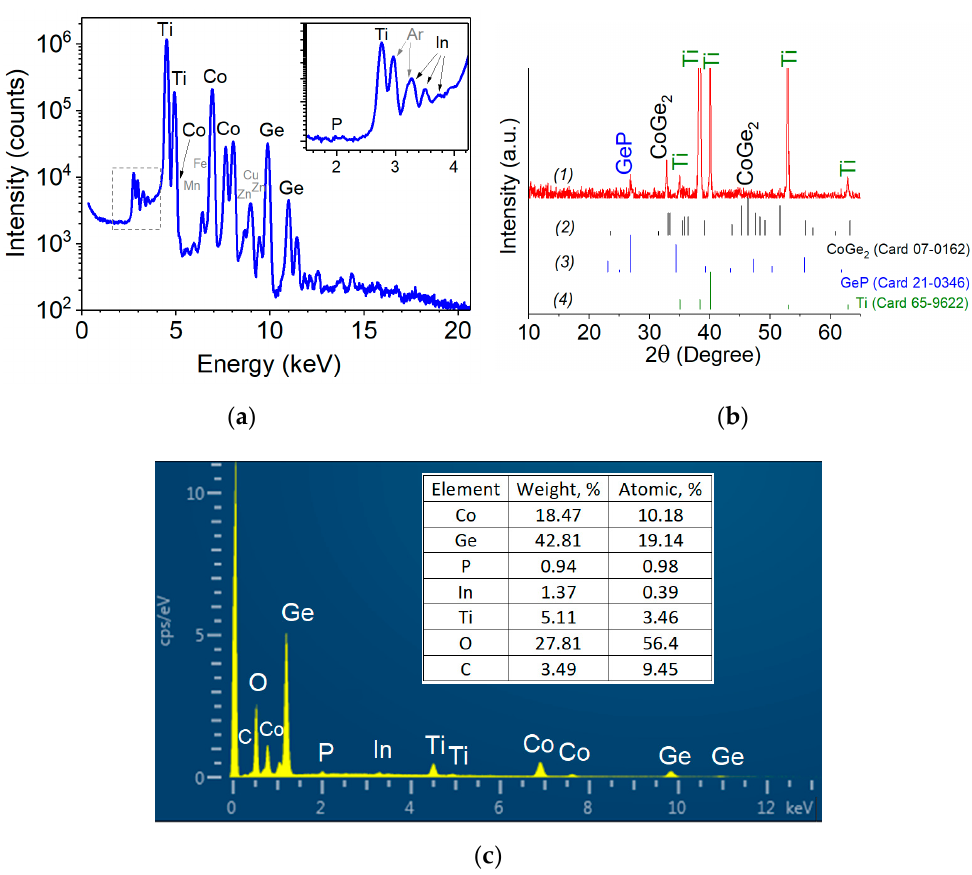
Figure 1. ( a ) X-ray fluorescence spectrum for Ge-Co-P nanostructures. Inset: a piece with larger magnification; ( b ) XRD patterns of (1) Ge-Co-P nanostructures; (2) orthorhombic CoGe 2 (Card No. 07-0162); (3) tetragonal GeP (Card No. 21-0346); (4) hexagonal Ti (Card No. 65-9622). Cards are taken from PDF-2 database.; ( c ) EDX spectrum for Ge-Co-P nanostructures.